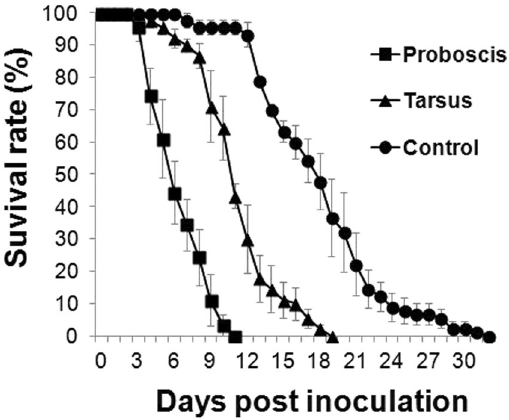
Figure 7. Comparison of survival rates after inoculation through the proboscis and tarsus routes. After fungal inoculation through the proboscis or tarsus, survival rates were measured until all mosquitoes were dead. Survival rates differed significantly among the proboscis inoculation, tarsus inoculation, and control groups (n = 90, p < 0.01, log-rank